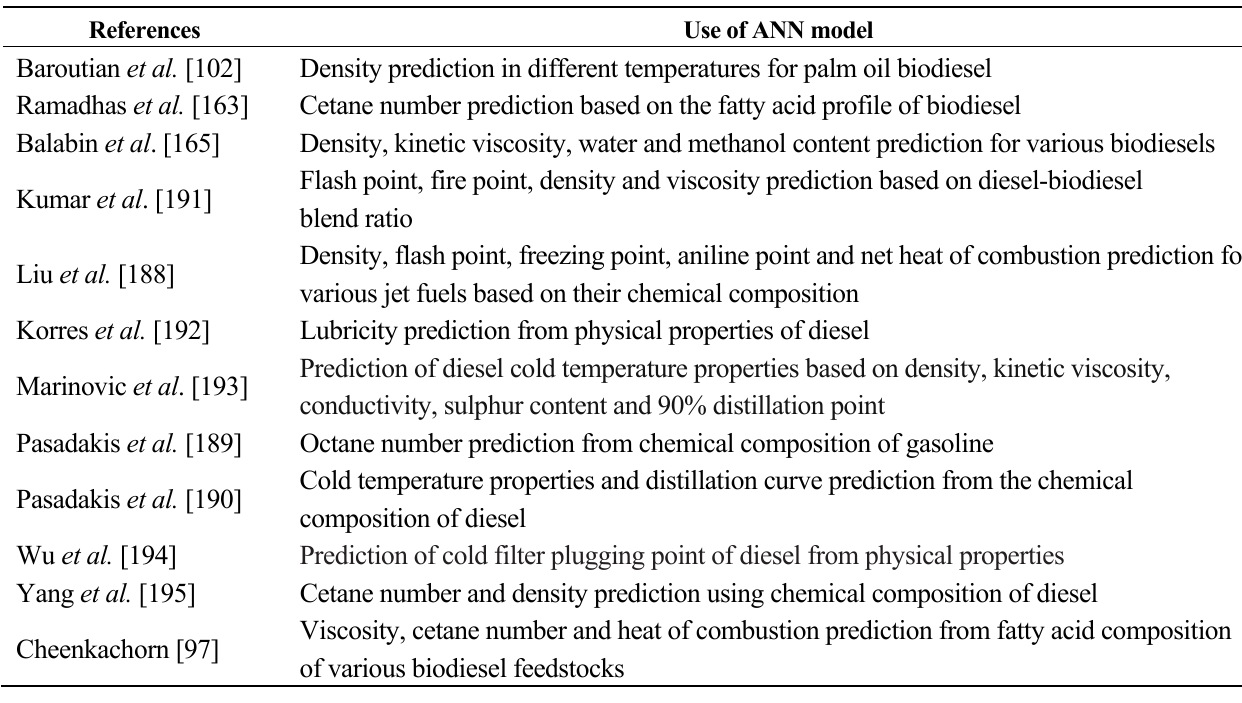
Table 8. ANN in predicting fuel